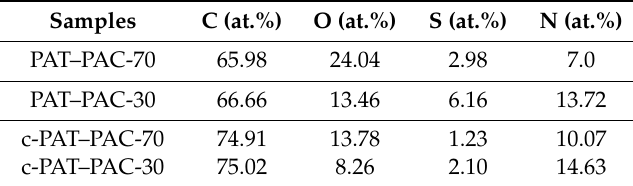
Figure 4. XPS spectra of the PAT–PAC and c-PAT–PAC. Table 1. XPS analysis of the PAT–PAC and c-PAT–PAC.